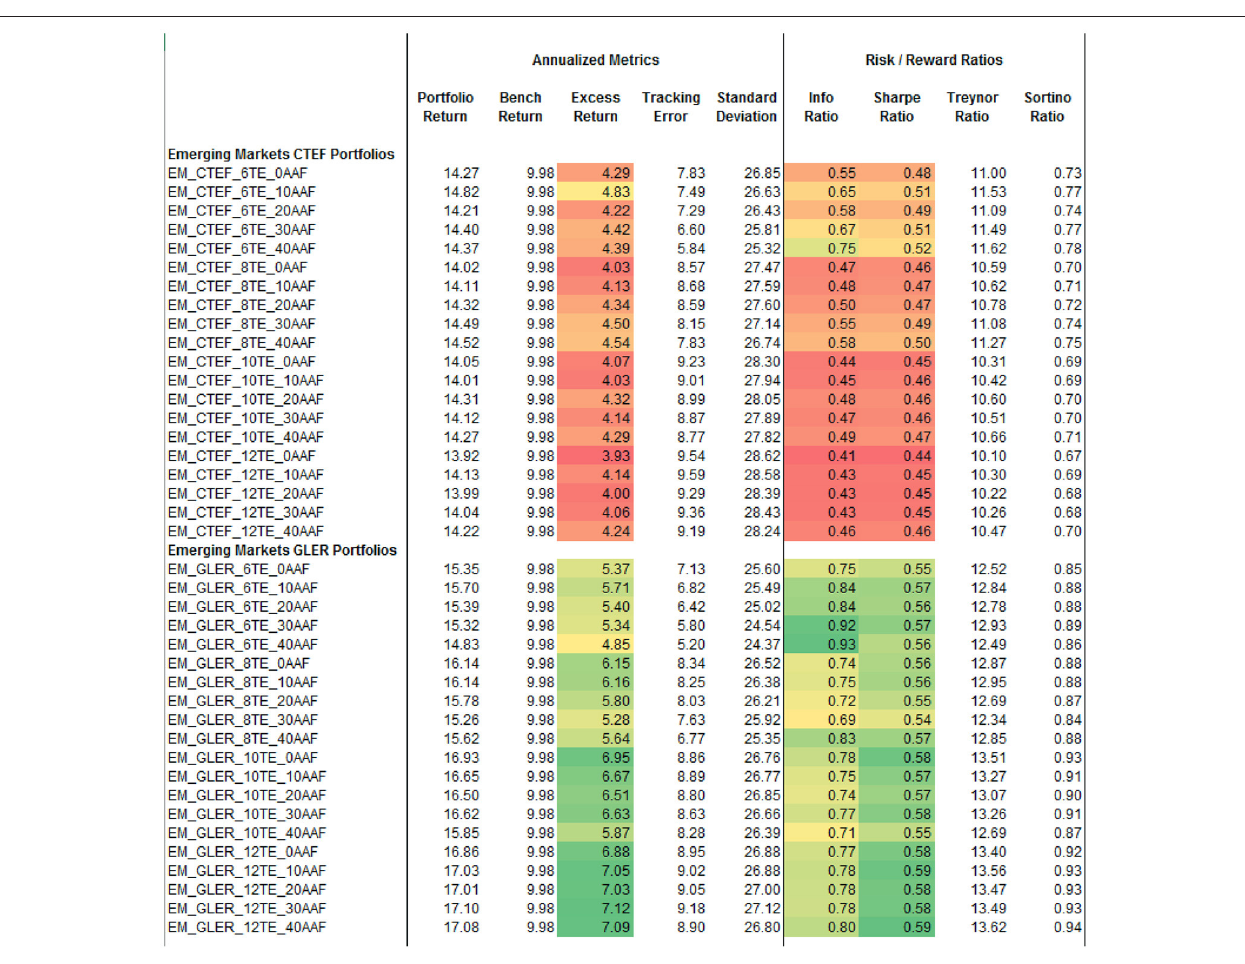
FIGURE 3 | Emerging market